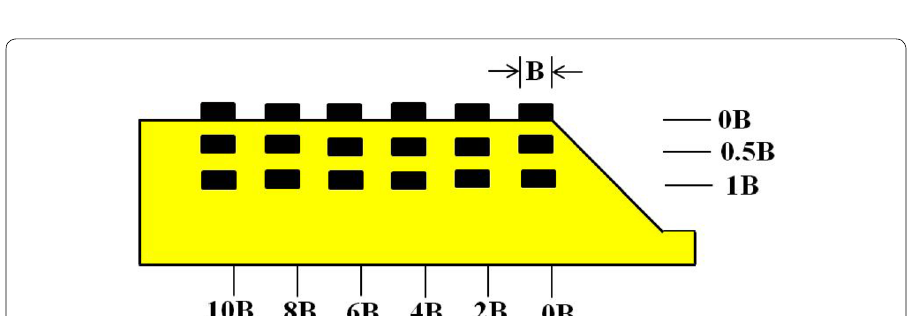
Fig. 3 Locations of surface and embedded footings in a sloping